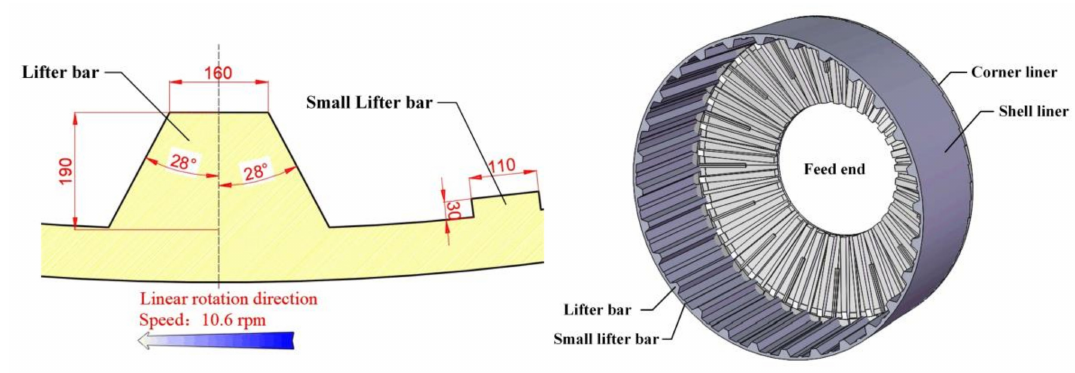
Figure 4. Cylinder model for simulation.